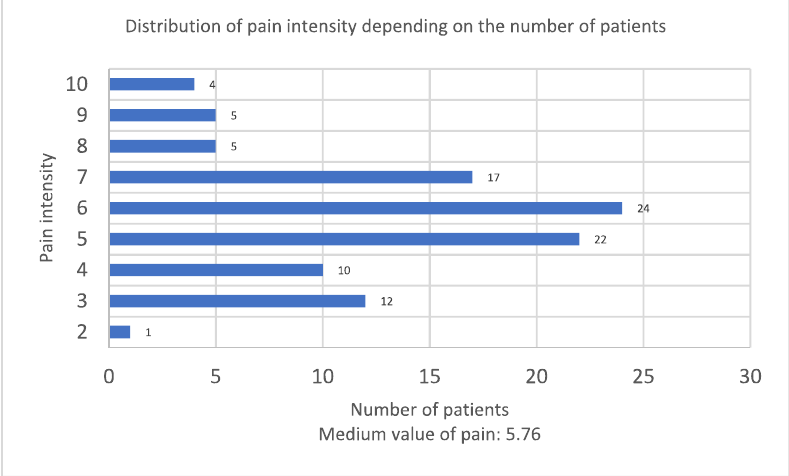
Figure 2. Distribution of pain intensity depending on the number of